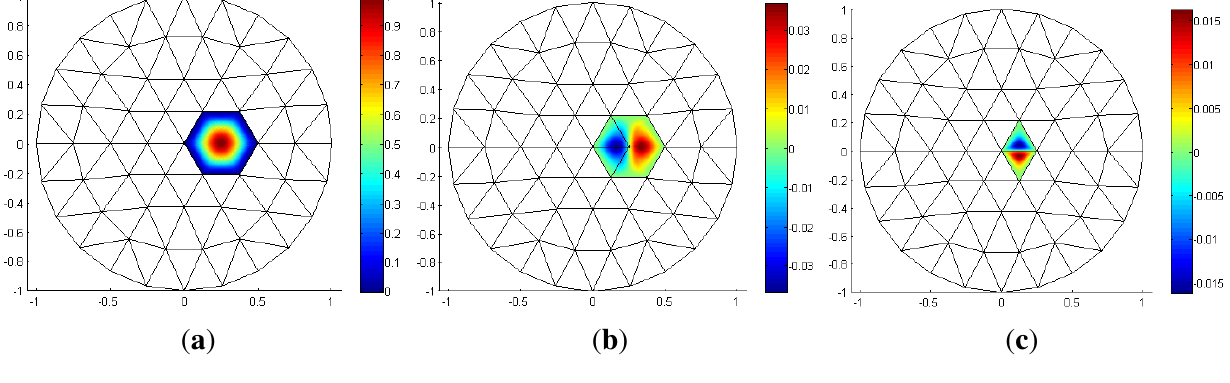
Figure 2. Hsieh–Clough–Tocher (HCT) basis functions (top view with height scale). ( a ) b (cid:52) : nodal basis function; ( b ) b (cid:52) 3 i derivative